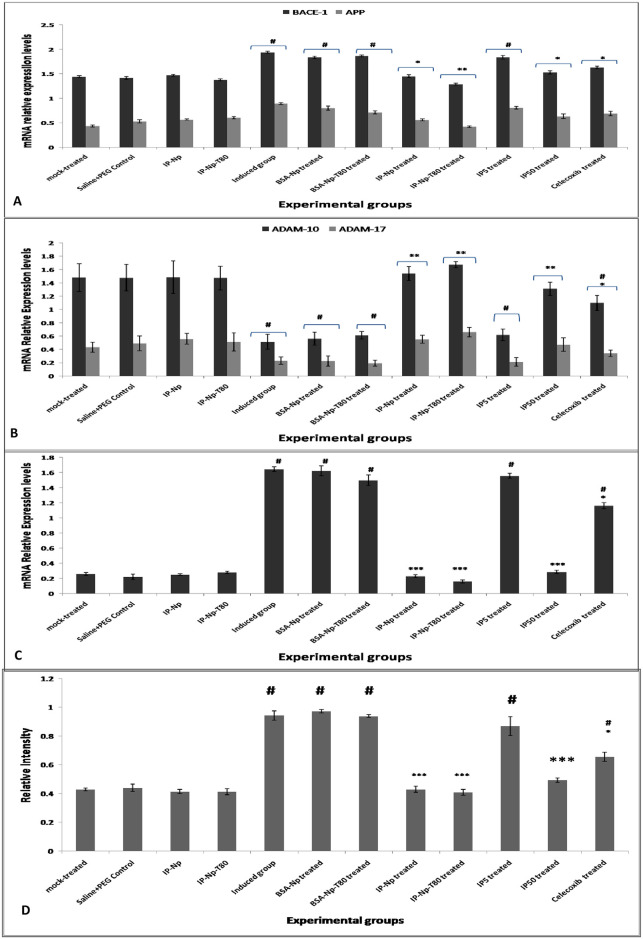
Alterations in gene expression of brain APP processing genes and changes in gene expression and protein levels of inflammatory transcription factor NF-κb.A) BACE-1 and APP, B) ADAM 10 and ADAM 17, C) NF-κB p65 and D) Representative Histogram of relative intensity of protein levels of NF-κB p65 of LPS-induced and treated groups versus control groups. Data represented as mean ± SD and p value is statistically significant at (***p≤0.001, **p≤0.01, *p≤ 0.05) compared to induced group and (#p≤ 0.05) compared to mock-treated group.